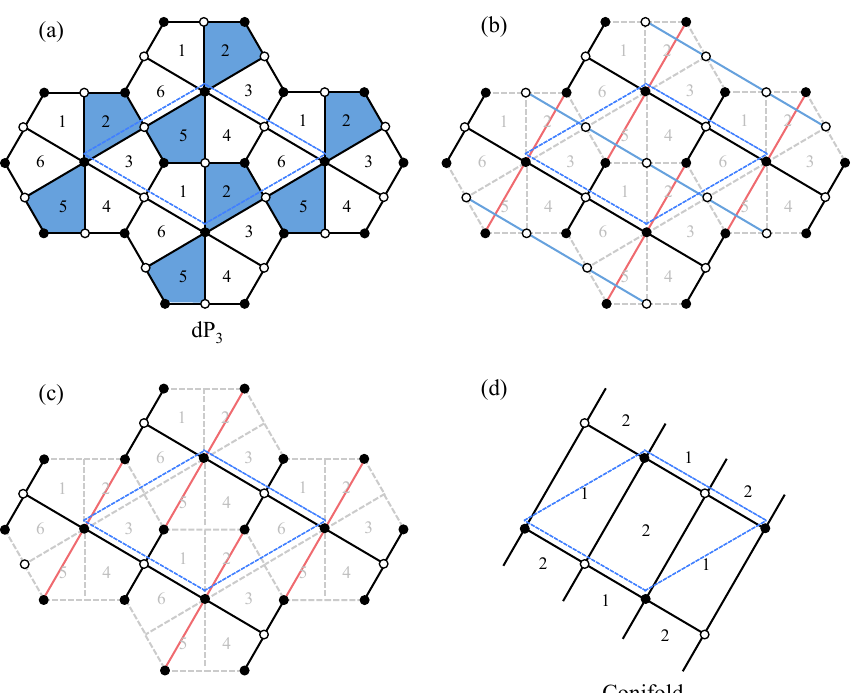
Figure 45. Instanton backreaction from phase 1 of dP 3 to the conifold.